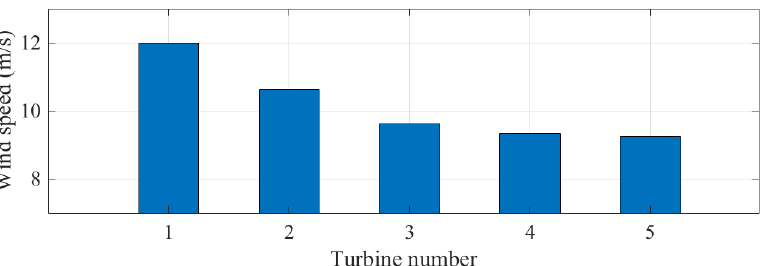
Figure 2. Wind farm layout.